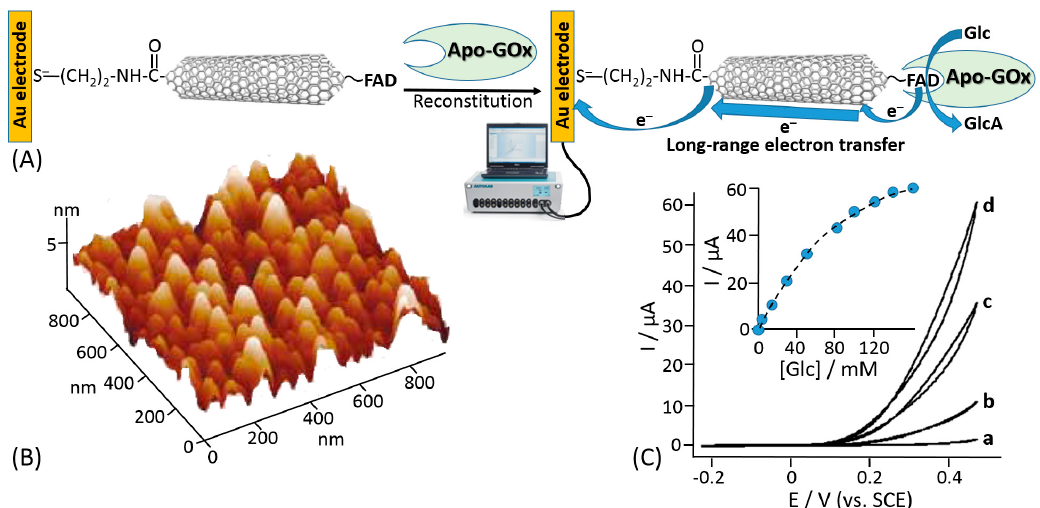
Figure 11. ( A ) Reconstitution of apo-GOx on FAD-functionalized carbon nanotubes operating as an electronically conducting nano-bridges facilitating long-range electron transfer from the reduced FAD active center to the electrode support. ( B ) Atomic force microscope (AFM) image of the GOx reconstituted on the FAD-functionalized carbon nanotubes monolayer associated with the Au electrode surface. ( C ) Cyclic voltammograms corresponding to the electrocatalyzed oxidation of di ff erent concentrations of glucose by the GOx reconstituted on the 25 nm-long FAD-functionalized carbon nanotube assembly: (a) 0, (b) 20, (c) 60 and (d) 160 mM glucose. Data recorded in phosphate bu ff er, 0.1 M, pH 7.4, scan rate 5 mV s − 1 . Inset: Calibration curve corresponding to the amperometric responses of the reconstituted GOx-electrode at E = 0.45 V in the presence of di ff erent concentrations of glucose. (Parts B and C were adopted from ref. [156] with